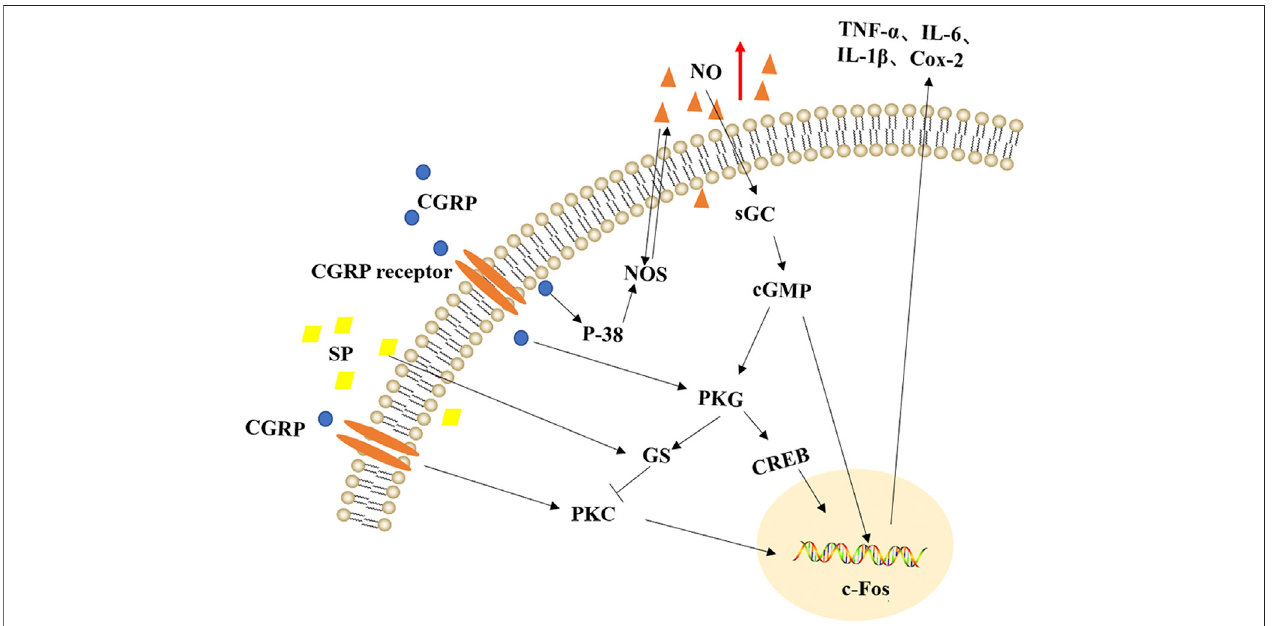
FIGURE 7 | The mechanism roadmap of nitroglycerin-induced migraine rats. NO, nitric oxide; SP, substance P; CGRP, calcitonin gene-related peptide; PKC, proteinkinaseC;cGMP,cyclicguanosinemonophosphate;PKG,proteinkinaseG;s-GC,Solubleguanylylcyclase;GS,(RefSeq)GproteinsubunitalphaL;CREB,cyclic adenosine monophosphate response element binding